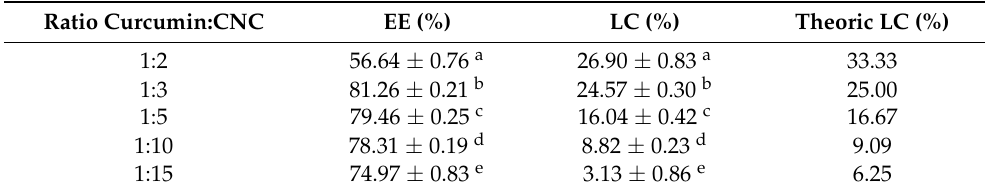
Table 2. Curcumin encapsulation efficiency (EE) and loading capacity (LC) (both experimental and theoric) of nanocellulose systems at different curcumin to nanocellulose ratios.